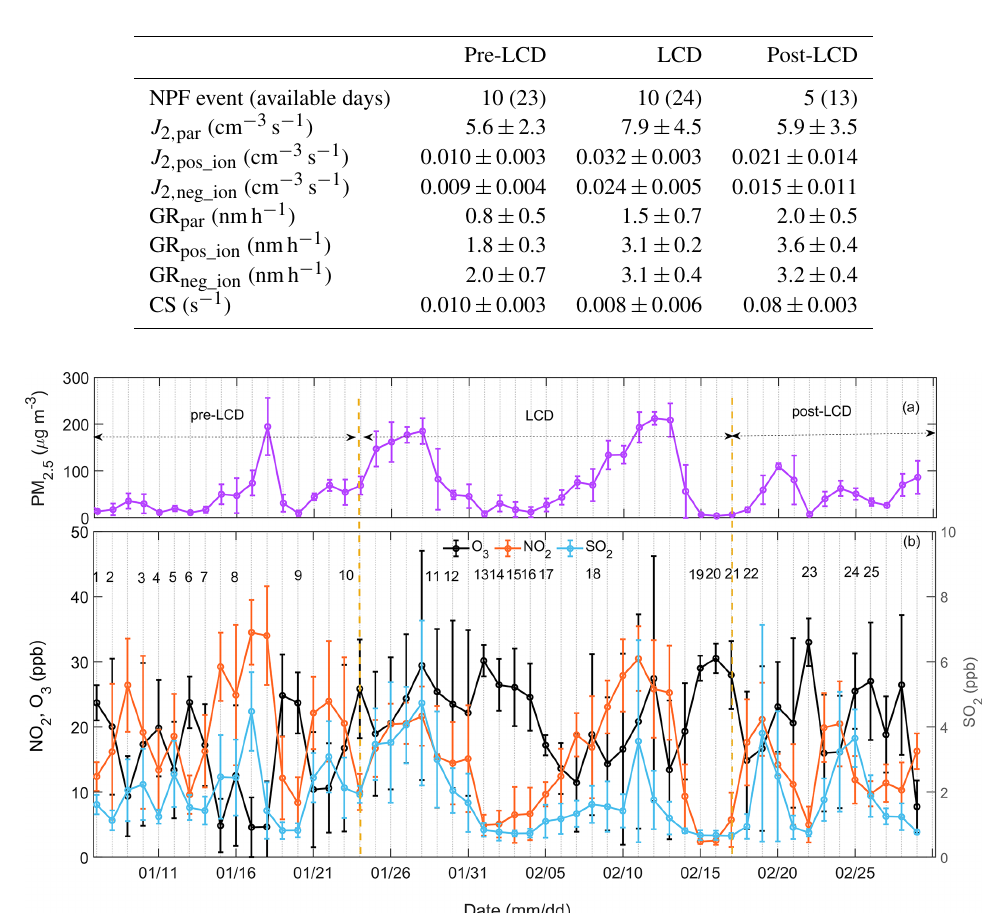
Figure 4. Concentration level of PM 2 . 5 mass concentration (a) and precursors (b) , including NO 2 , SO 2 , and O 3 during the measurement period. The circle and bar indicate the mean and standard deviation, respectively; NPF days are marked with continuous numbers